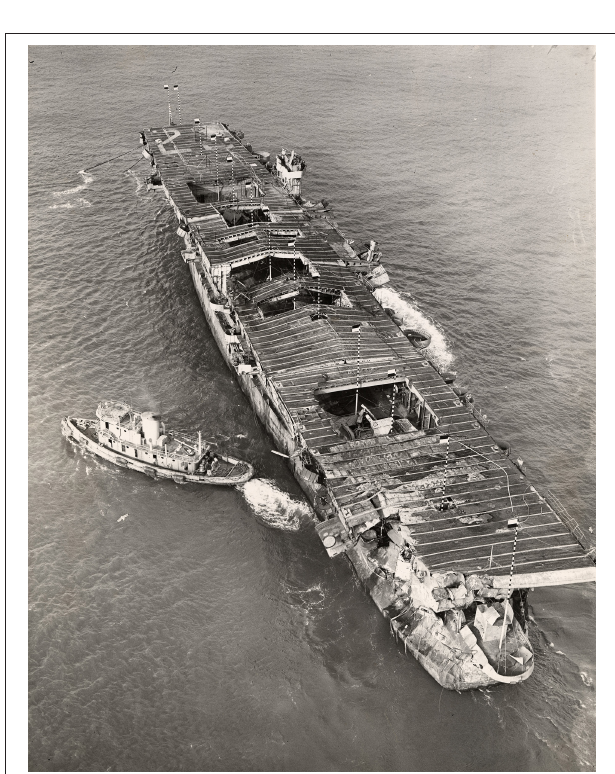
FIGURE 5 | The ex-USS Independence on San Francisco Bay, prior to being towed out for sinking (San Francisco Maritime National Historical Park).